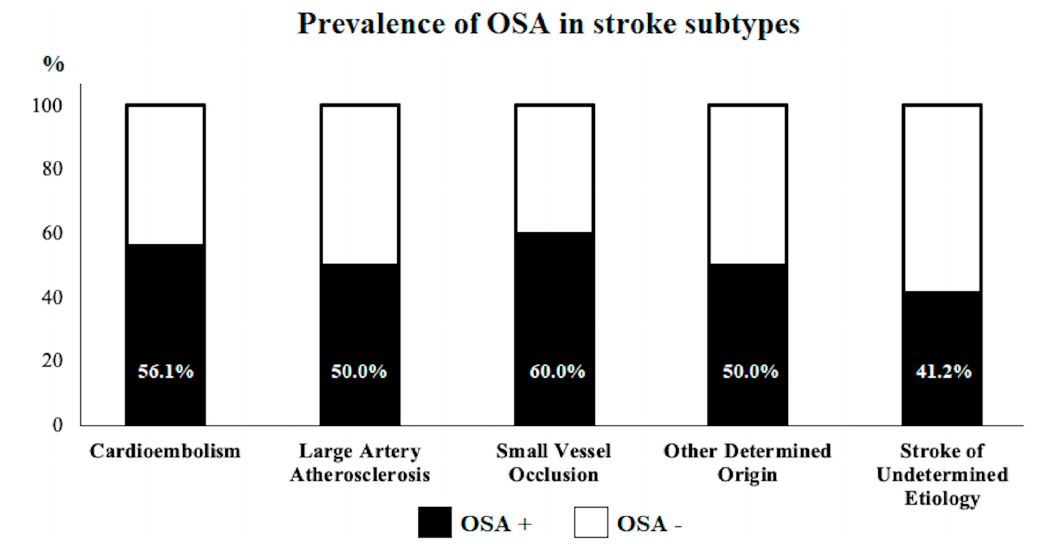
Figure 1. Prevalence of OSA according to the stroke etiology. Table 2. Univariate comparison between OSA+ and OSA − groups.